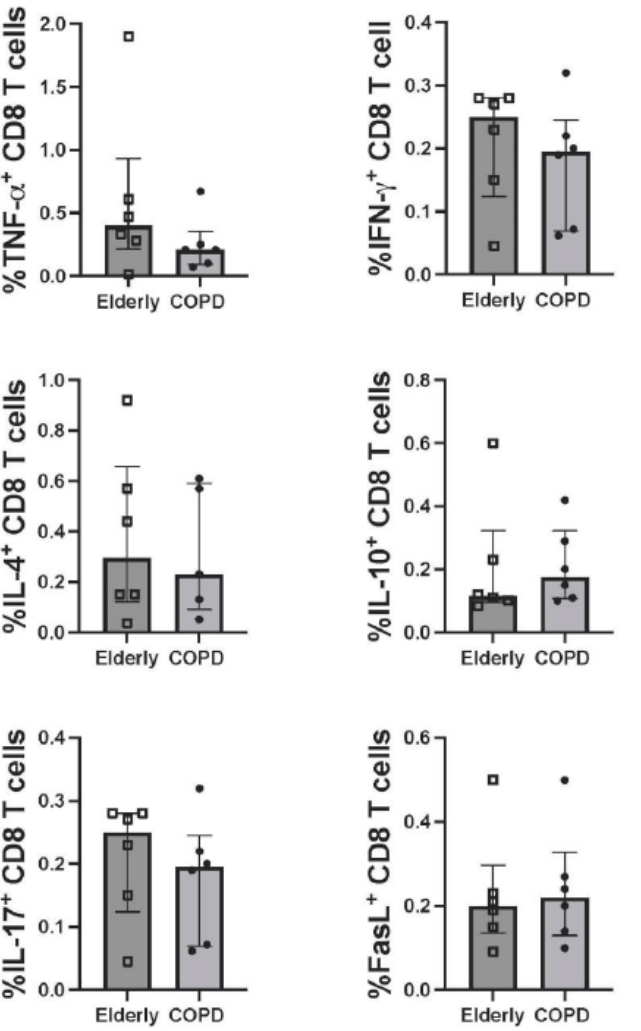
Figure 3. CD8 T-cell responses to pooled peptides of SARS-CoV-2 wild-type spike proteins. Note: PBMCs obtained from COPD (N = 6) and healthy elderly ( n = 6) at 4 weeks after ChAdOx-1/ChAdOx-1 homologous vaccination were stimulated with pooled peptides of the wild-type spike protein (all functional domains) and analyzed for the expression of molecules of interest using immunofluorescence staining and flow cytometry. The graphs indicate frequency of CD4 T-cells expressing TNF- α , IFN- γ , IL-4, IL-10, IL-17A and FasL. Individual data of each study group are shown. Lines represent the median with the interquartile range. The Mann–Whitney U test was used for comparisons. All data are no statistically significant difference ( p > 0.05).